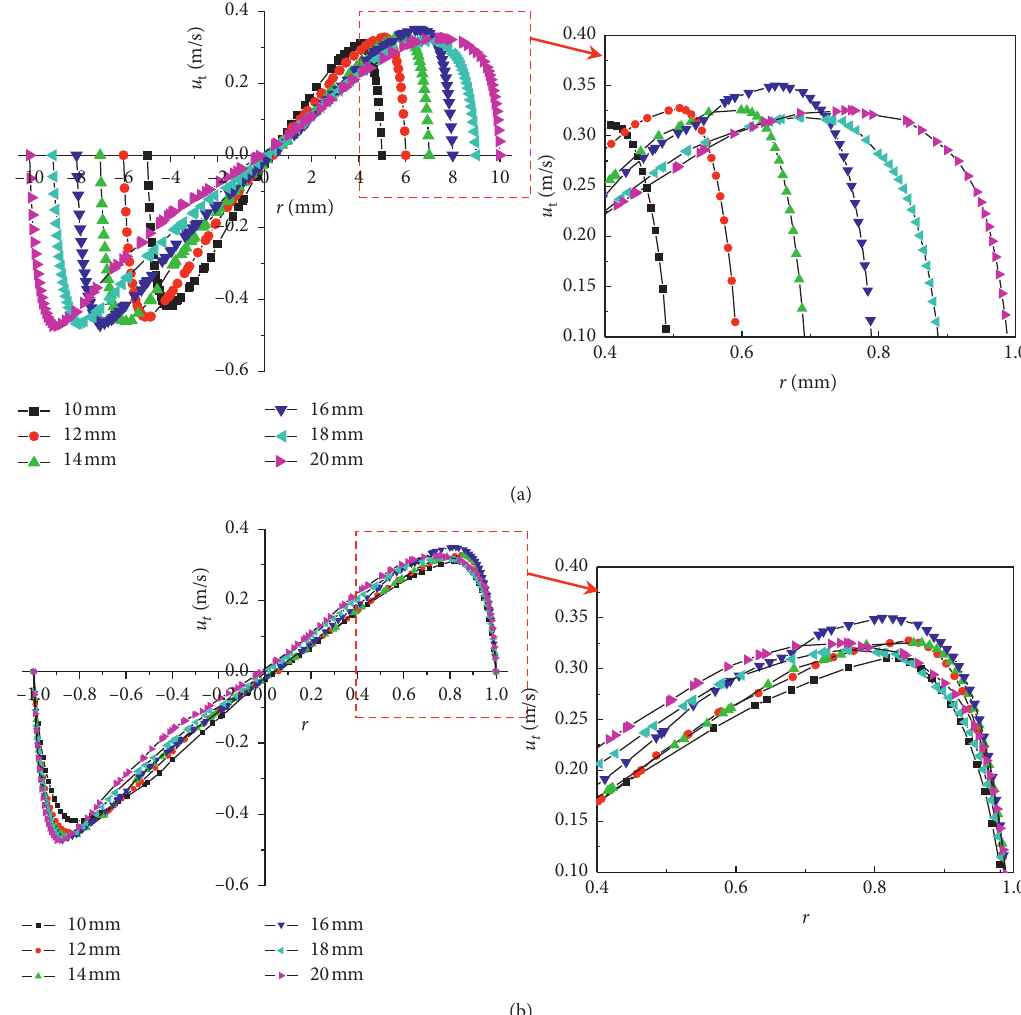
Figure 11: Tangential velocity distribution of Y